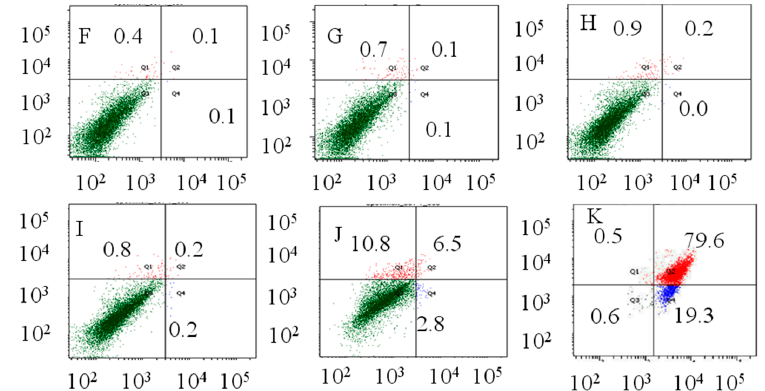
Figure 2. Apoptosis and necrosis quantification. ( A ) Control; ( B ) 0.1; ( C ) 0.2; ( D ) 0.5; ( E ) 1.0; ( F ) 2.0;